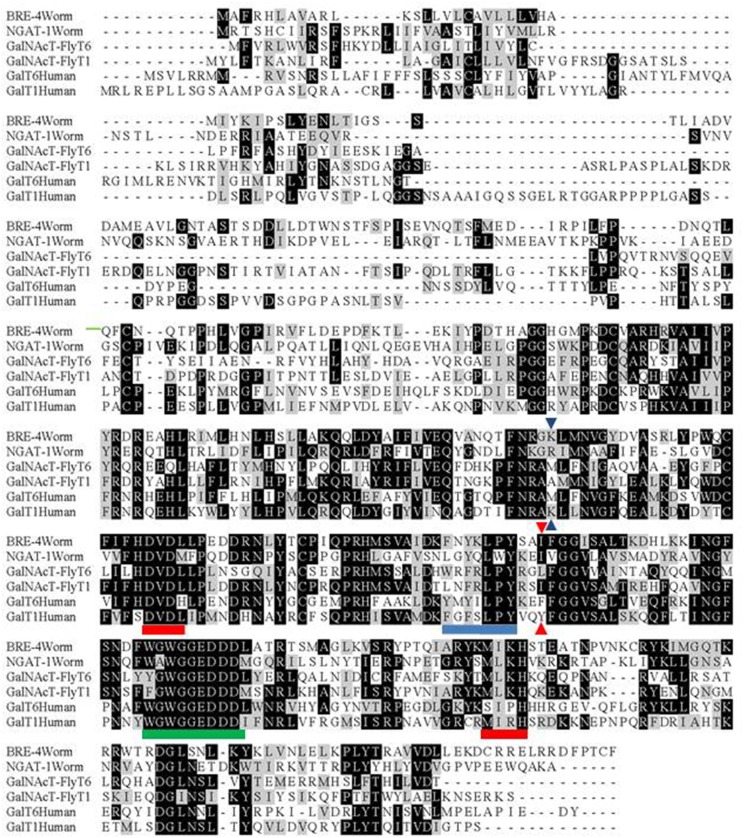
Comparison of galactosyl transferases from C. elegans, D. melanogaster (fly), and humans.Alignments were made of the most closely-related C. elegans (wormbase), fly (FBgn0027538, FBgn0031495) and human (Q8NCL4, Q10472) galactosyltransferases using CLUSTAL [47]. The ngat-1(ev821) nonsense mutation is indicated by blue triangles and the position of the Leu (or in this case Ile) residue, which specifies N-acetylgalactosamine transfer (vs Tyr or Phe, which do not) [48] is indicated by red triangles. Metal ion (red underline), acceptor (blue underline), and donor (green underline) binding sites as predicted from human galactosyl transferases [45]. Identical residues are shaded black and similar residues are shaded grey.